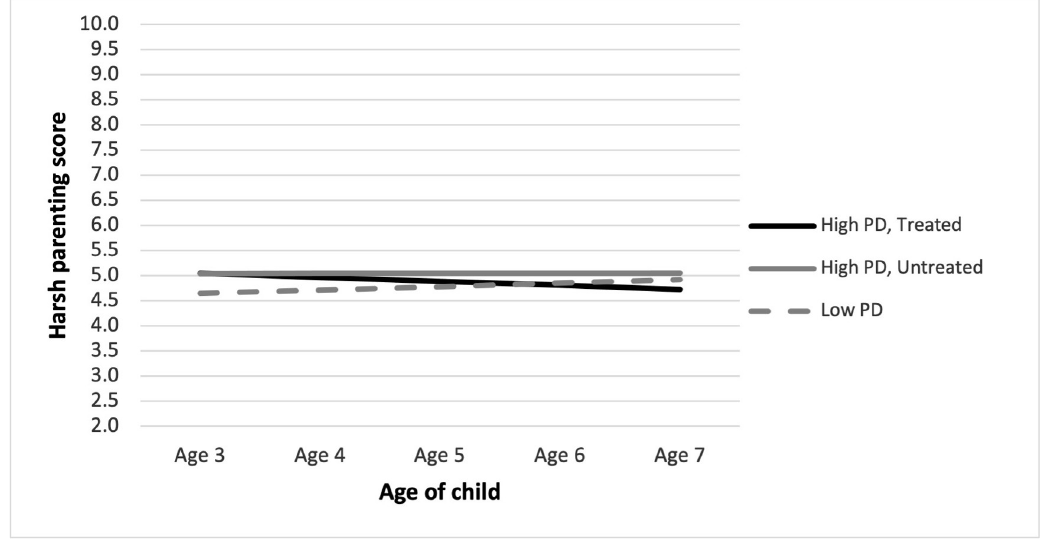
Fig 2. Predicted harsh parenting trajectories by high/low psychological distress and treatment status (Fully-adjusted Model 3). Note : Predictions are plotted for the reference group for each categorical variable and at the mean of each continuous variable.